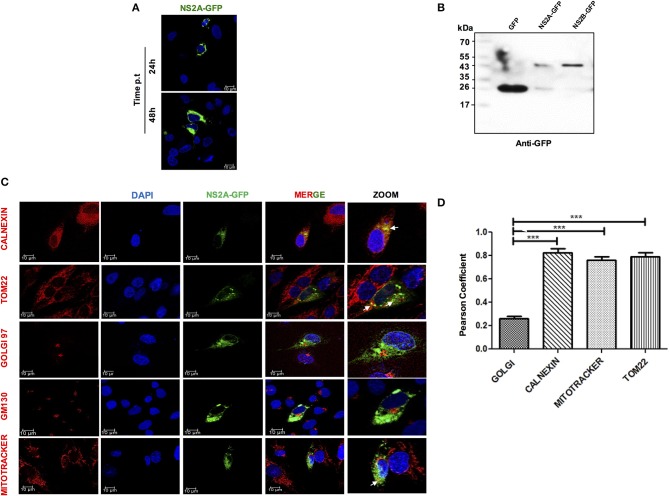
Expression and localization of NS2A protein in HMEC-1 cells. (A) HMEC-1 cells were transiently transfected with plasmids coding for NS2A-GFP and analyzed at 24 and 48 h. Cells were fixed and analyzed by confocal microscopy (B). HMEC-1 cells were transiently transfected with the plasmids coding for GFP and the NS2A-GFP protein and cell lysates were analyzed by western blot using an anti-GFP antibody (1:1,000). Lane 1: molecular weight (MW), Lane 2: pEGFPN1 transfected lysate, Lane 3: pNS2A-GFP transfected cell lysate showing band of GFP (27 kDa) as well as NS2A-GFP (48 kDa) and NS2B-GFP (43 kDa) (C). To evaluate the localization of the NS2A protein, HMEC-1 cells were transfected with a plasmid encoding GFP-tagged DENV-2 NS2A and stained with either anti-calnexin (ER Marker; red), anti-GM (Golgi marker; red), MitoTracker (mitochondrial marker; red) or TOM22 (mitochondrial outer membrane marker, red) and observed with a confocal microscope 24 h after transfection (D). Pearson's Coefficient of the NS2A-GFP localization in different membrane organelles. ***P < 0.001.